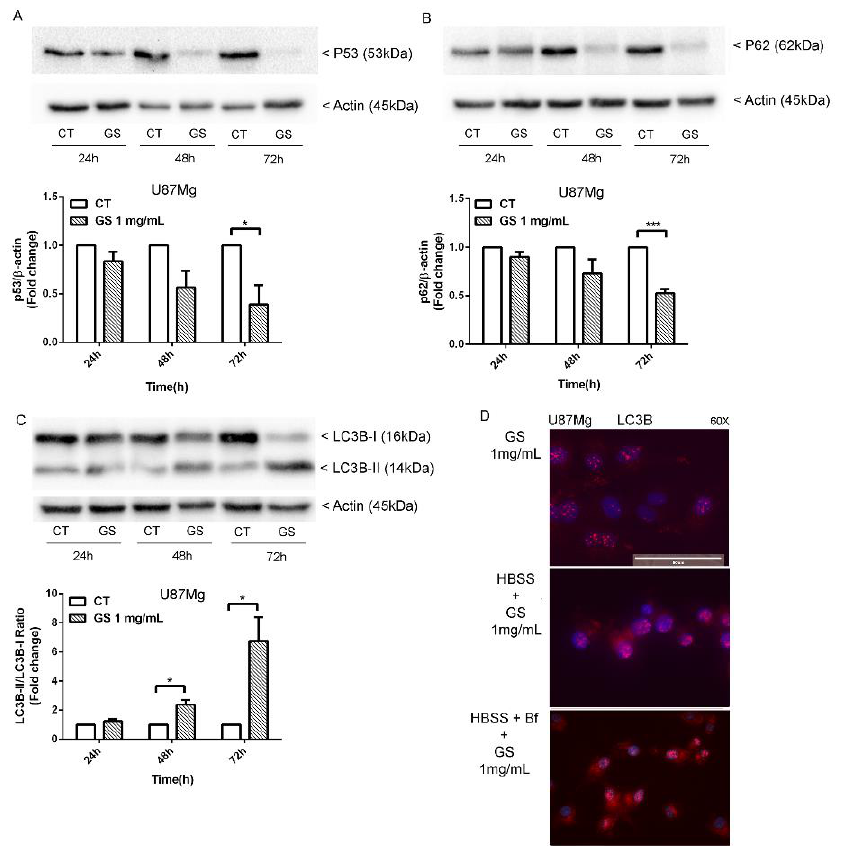
Figure 4. Autophagy modulation by GS extract. Western blot of U87Mg treated, respectively, with GS 1 mg/mL and DMSO 0.3% as vehicle control for 24, 48, and 72 h showed a reduction in p53 ( A ) and P62 ( B ) protein levels, and a decrease in LC3B- I with an increase in active form LC3B-II ( C ). Densitometric analysis of protein levels represent the means ± SEM of 3 individual determinations. Data were normalised to housekeeping gene Actin and are expressed as fold change over control- treated cells. * Unpaired t -test. According to GraphPad Prism, * p -value 0.01 to 0.05 (significant), *** p -value 0.0001 to 0.001 (Extremely significant). ( D ) Immunofluorescence of LC3B puncta, which were more evident after autophagy blocking with Bafilomycin A1 (Bf). Magnification 60 × with Evos FL microscope.